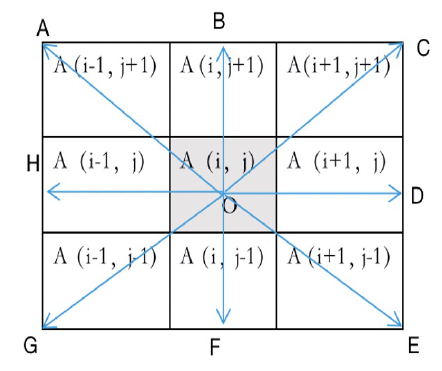
Figure 3. Wind speed decomposition